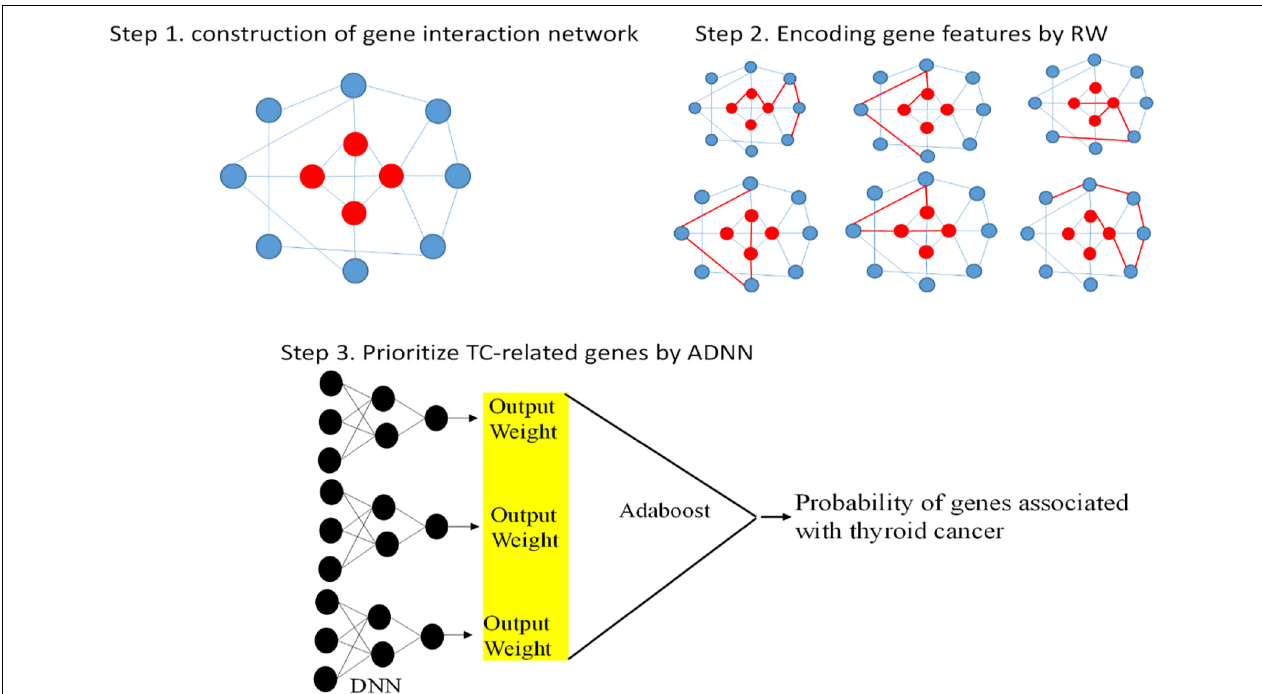
FIGURE 1 | Three steps of ADNN to prioritize genes related to thyroid cancer.